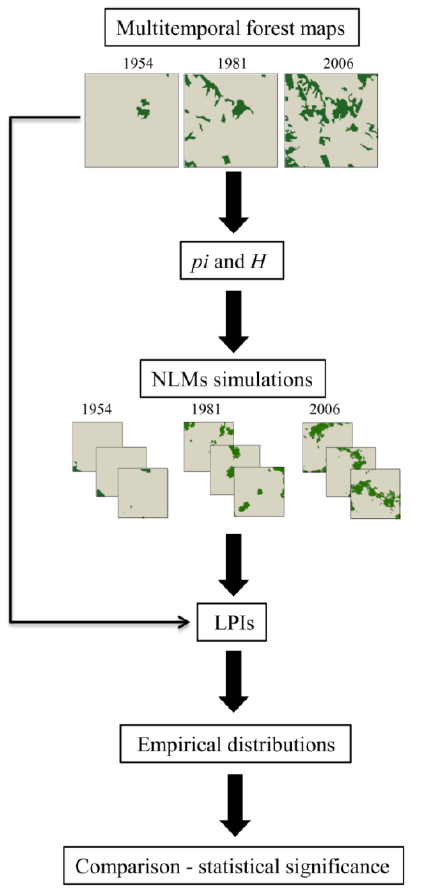
Figure 2. Proposed framework for comparing and testing differences of forest pattern over time.